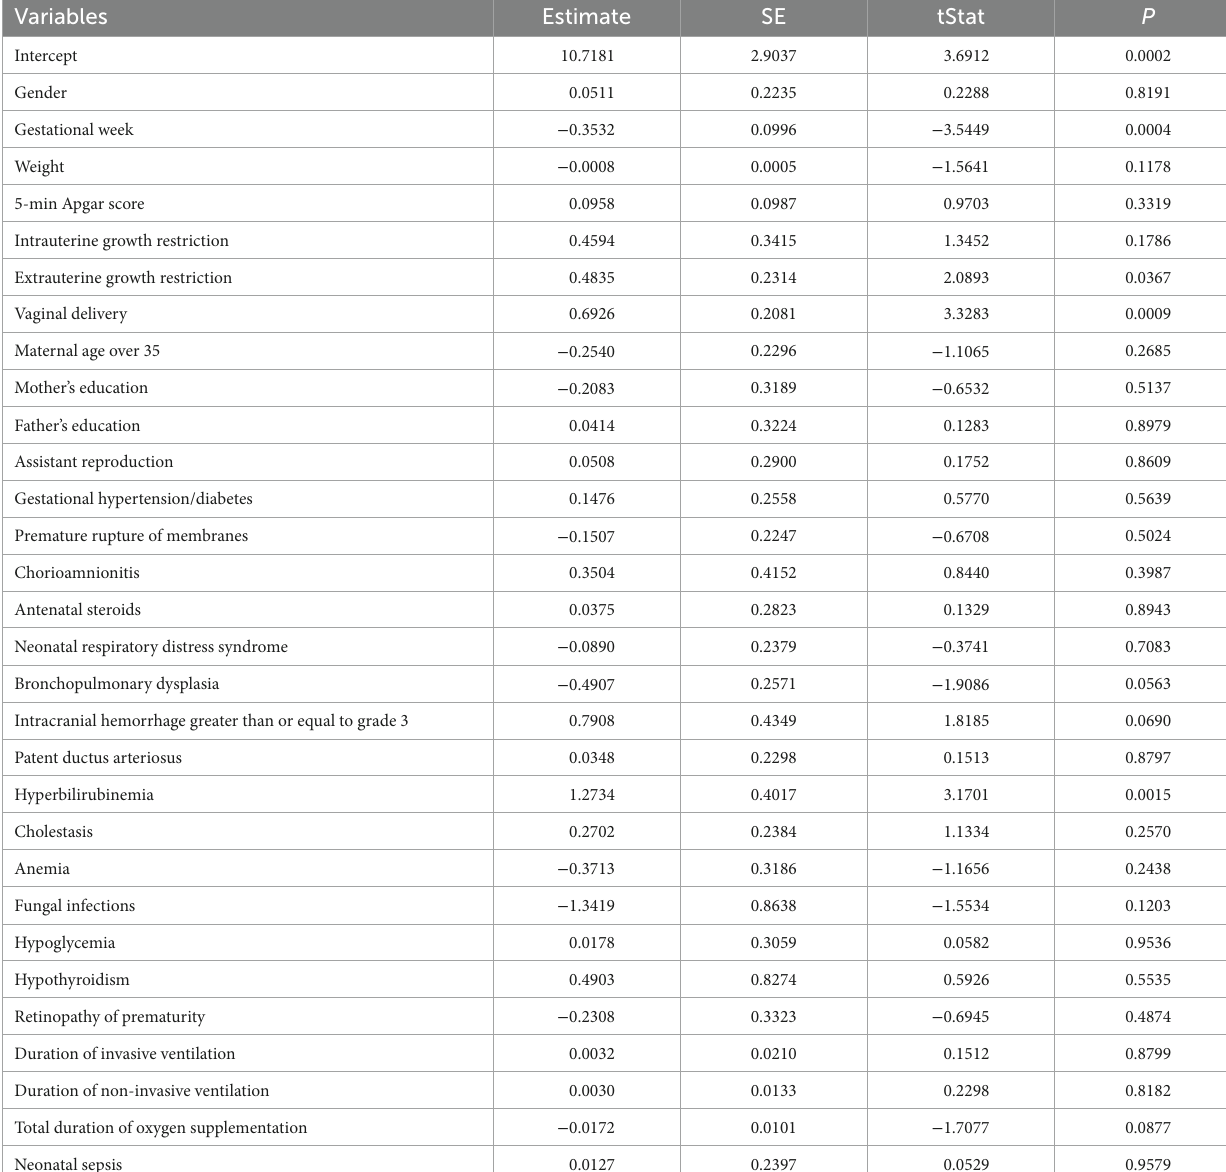
TABLE 1 Multivariate logistic regression analyses for screening predictors.